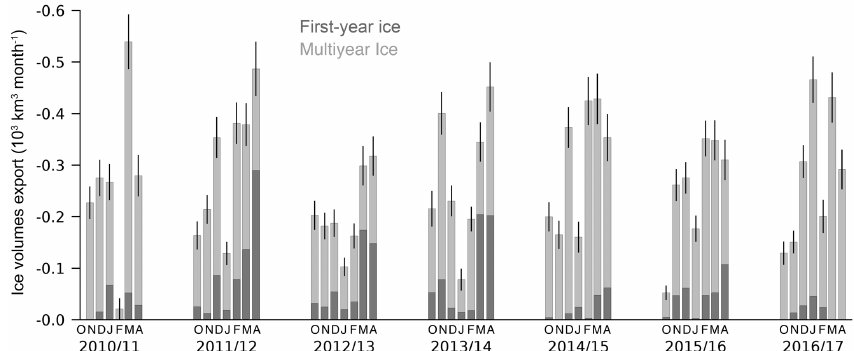
Figure 6. Monthly sea ice volume export through Fram Strait from October to April for the period 2010–2011 and 2016–2017, using the OSI SAF ice drift product. The volume export is divided into first- and multi-year sea ice. Uncertainties are represented by error bars. October 2010 data are missing due to the unavailability of CryoSat-2 data.